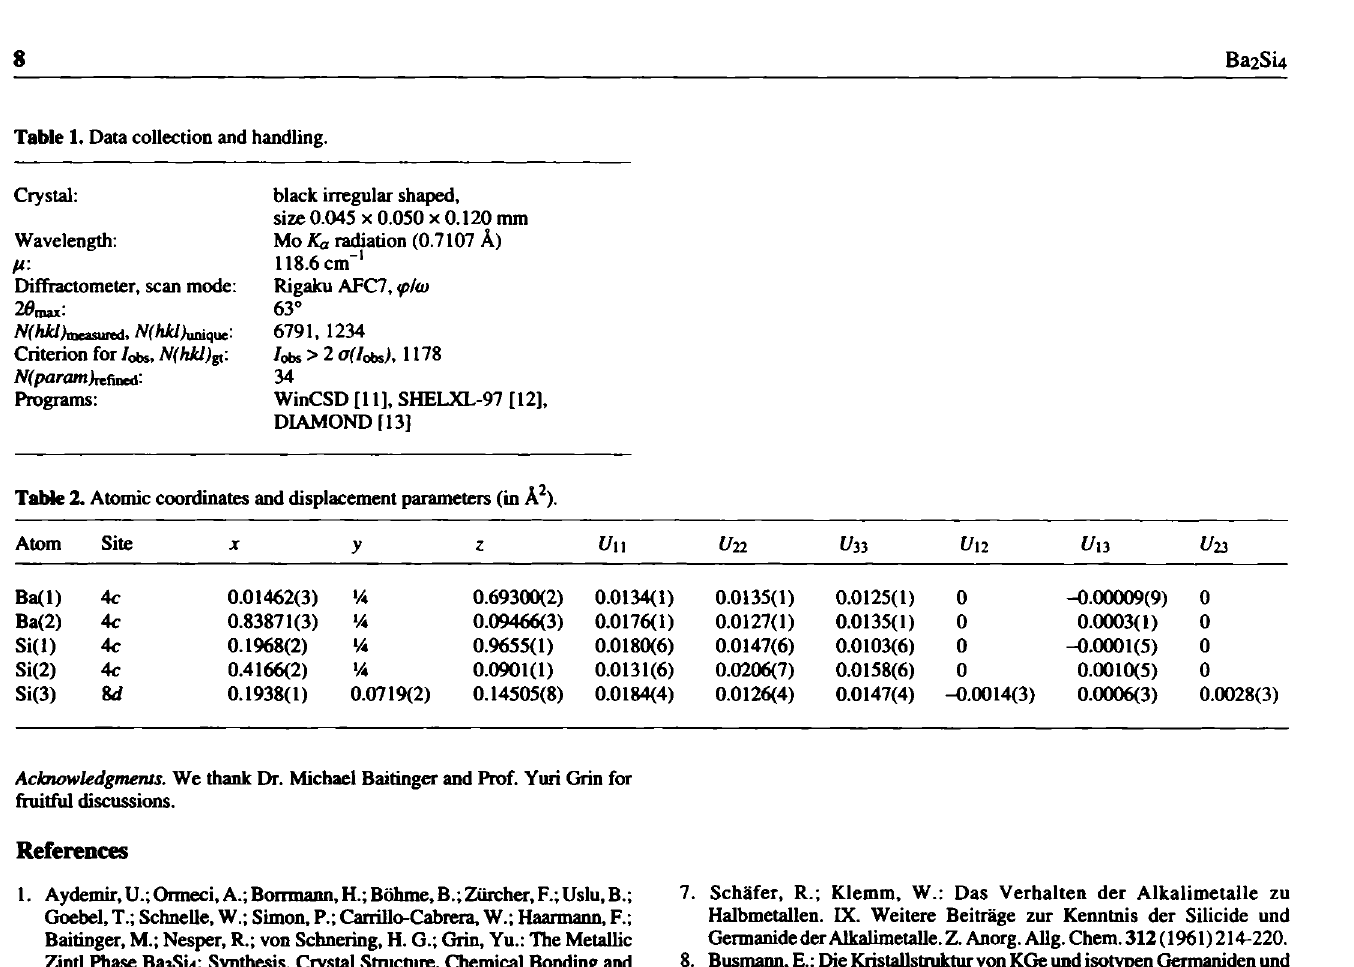
Table 2. Atomic coordinates and displacement parameters (in A 2